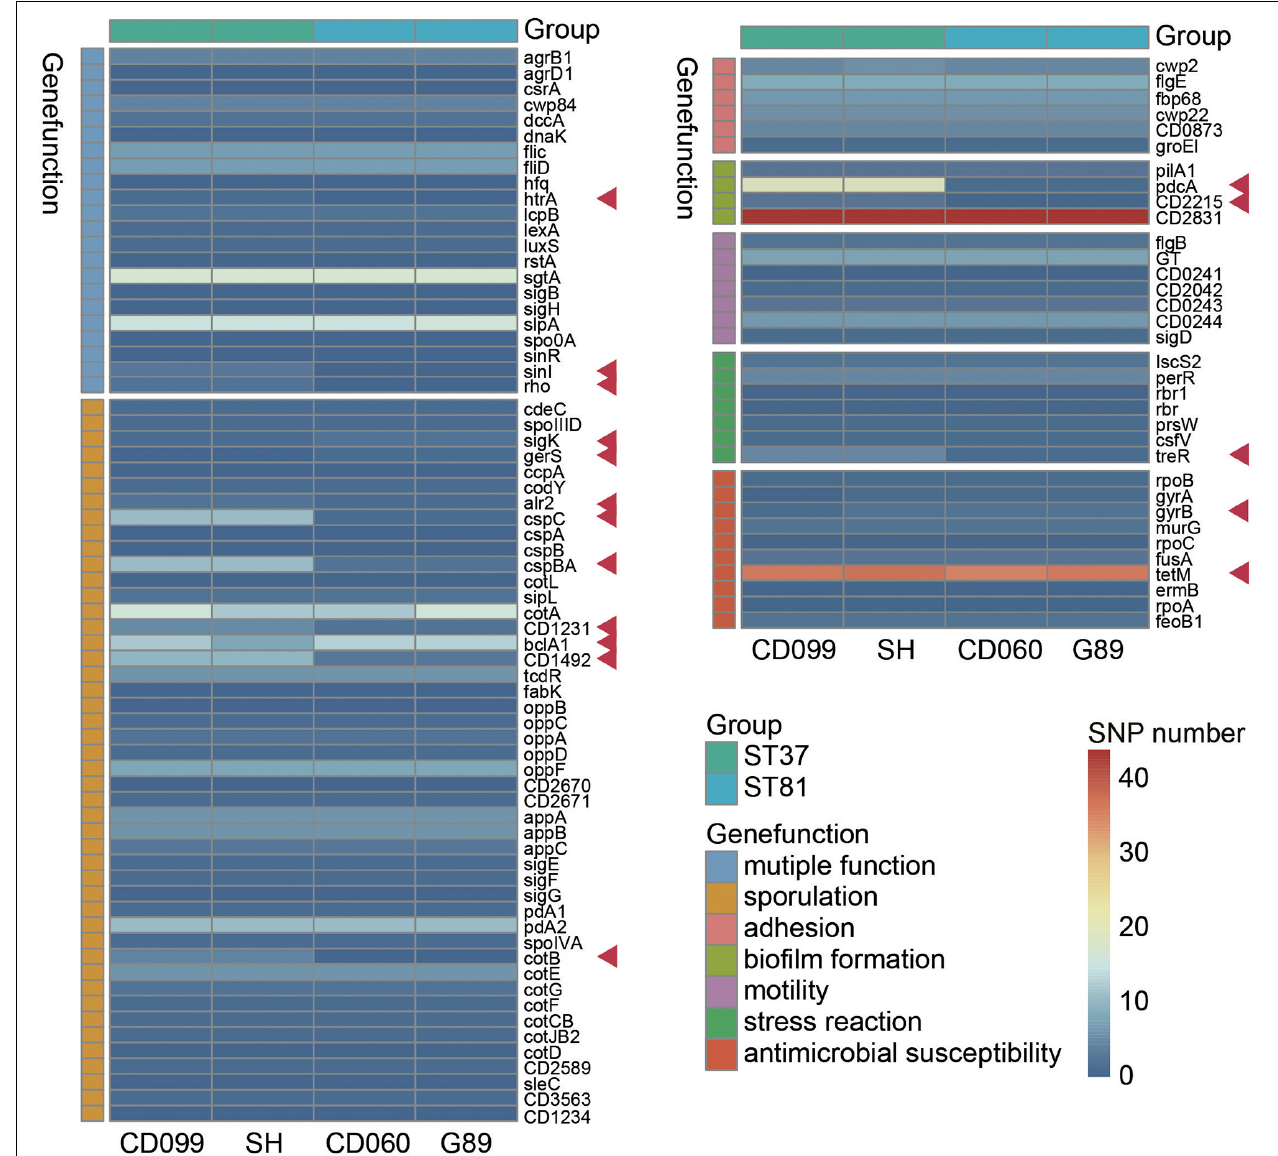
FIGURE 3 | Functional analysis of non-synonymous SNPs in variant genes among the ST81 and ST37 isolates. Genes clustered in the same color refer to the same gene function indicated aside. The ST81 and ST37 isolates are labeled below and marked in light blue and light green, respectively. The colors from blue to red in the middle represent the number of SNPs identified. Genes with different numbers of SNPs between STs are indicated by red